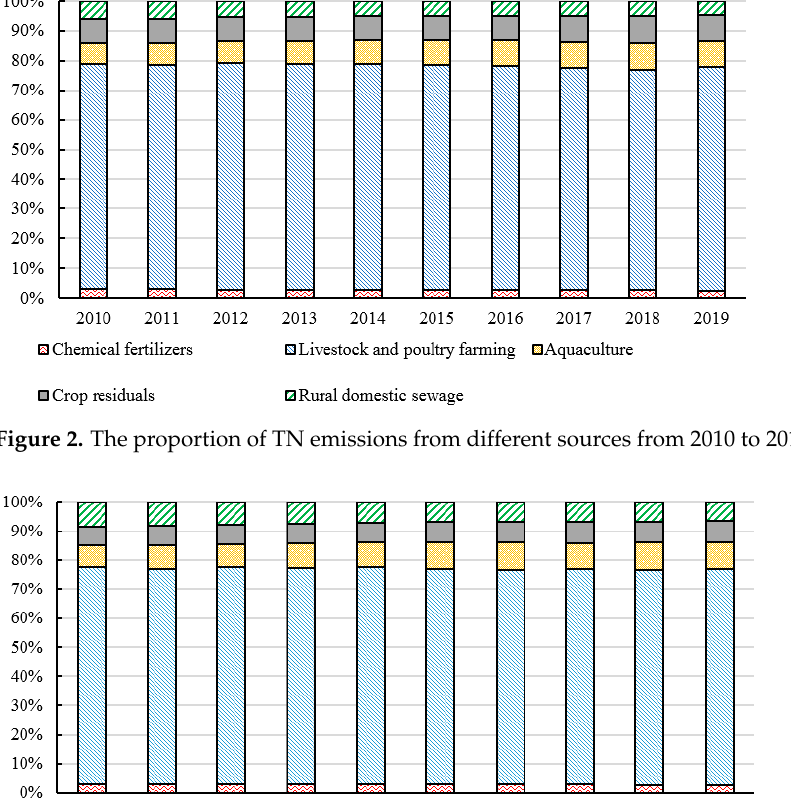
Figure 1. Average amount of TN, TP, and COD emissions from 2010 to 2019.